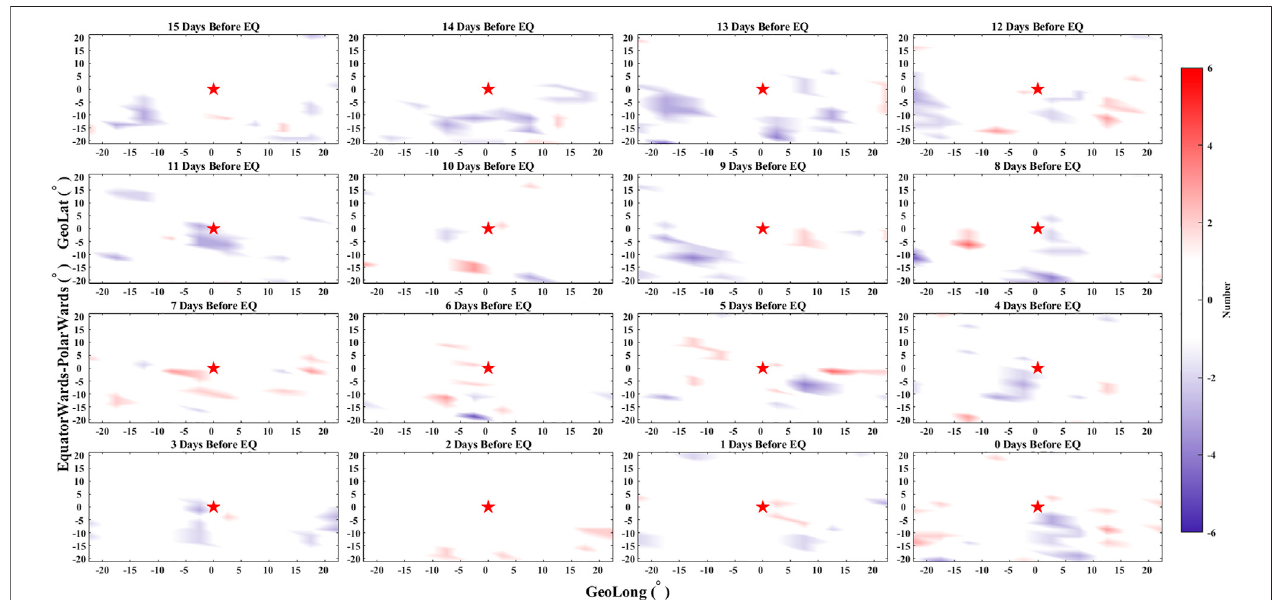
FIGURE8 | Distributions of Ne anomalies from 15 days before earthquakes tothe occurrence day. The red star represents the epicenter. In each subplot, X and Y axesaredegreesfromtheepicenterinthegeographiclongitudeandgeographiclatitude,respectively.Thedaysbeforeearthquakesaremarkedonthetopofeachpanel.